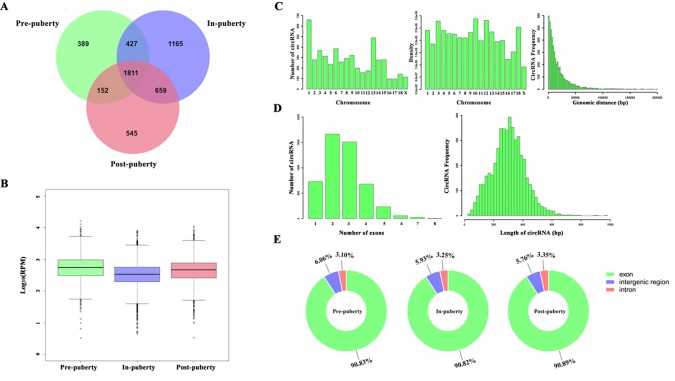
Identification of pituitary-derived circRNAs during the onset of puberty in pigs. (A) The Venn diagram of circRNAs detected in pre-, in-, and postpuberty; (B) Distribution and genomic distance of the circRNAs; (C) Proportion of circRNAs that originated from the exon, intergenic, and intronic regions; (D) The exon number of the circRNAs; (E) Distribution and transcript length of the circRNAs.